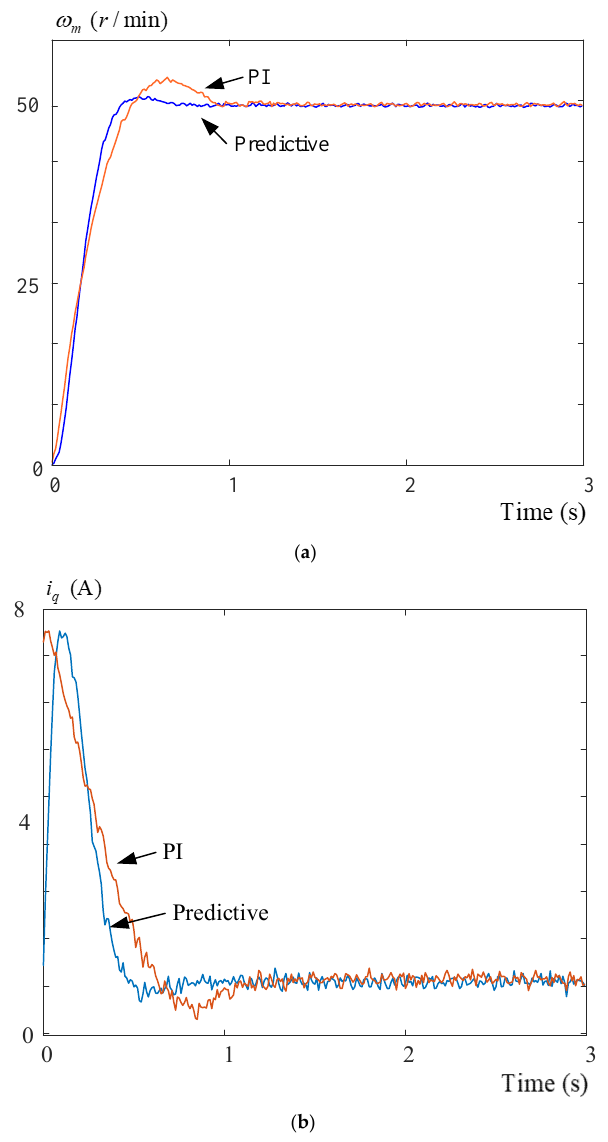
Table 1. Comparisons of predictive controllers and PI controllers. Conditions